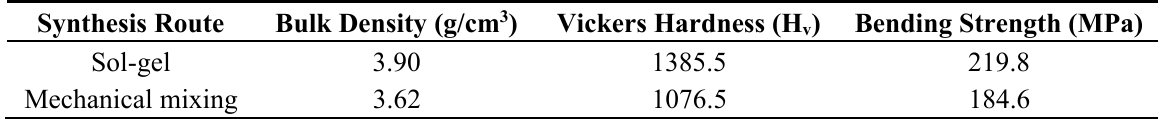
Table 2. Physical and mechanical properties of sol-gel and mechanical mixing-derived composites, sintered at 1650 °C for 1 h